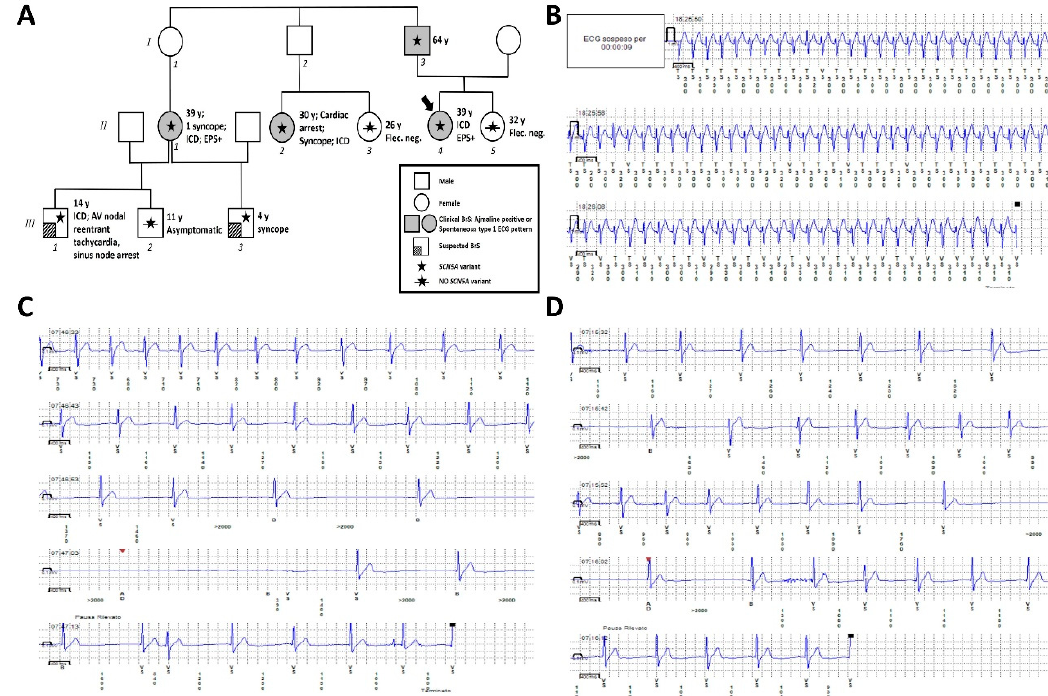
Figure 4. ( A ) Family pedigree. Proband identified with arrow. Square: male; circle: female; shaded background: ajmaline positive or spontaneously occurring type one Brugada syndrome (BrS) ECG pattern; lined bottom left corner: BrS clinically suspected; star: molecularly confirmed SCN5A variant; star with slash: genetic test for SCN5A variant performed but negative; y: years old at first diagnosis. ( B ) Atrioventricular nodal reentrant tachycardia of Patient III-1 detected by loop recorder. ( C ) Sinus node arrest associated with syncope in Patient III-1 detected by loop recorder. ( D ) Sinus node arrest associated with dizziness during fever in Patient III-1 detected by loop recorder.